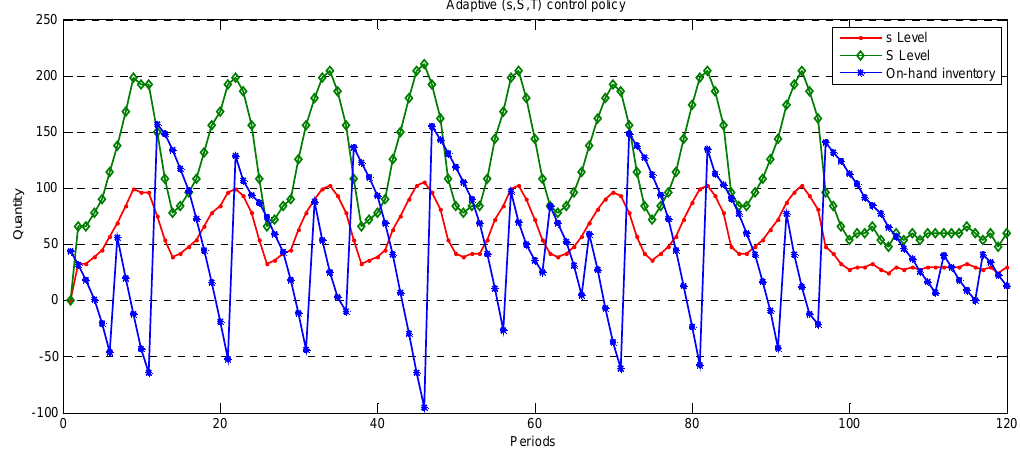
Fig.17. Inventory adjustment process under adaptive (s,S,T) control